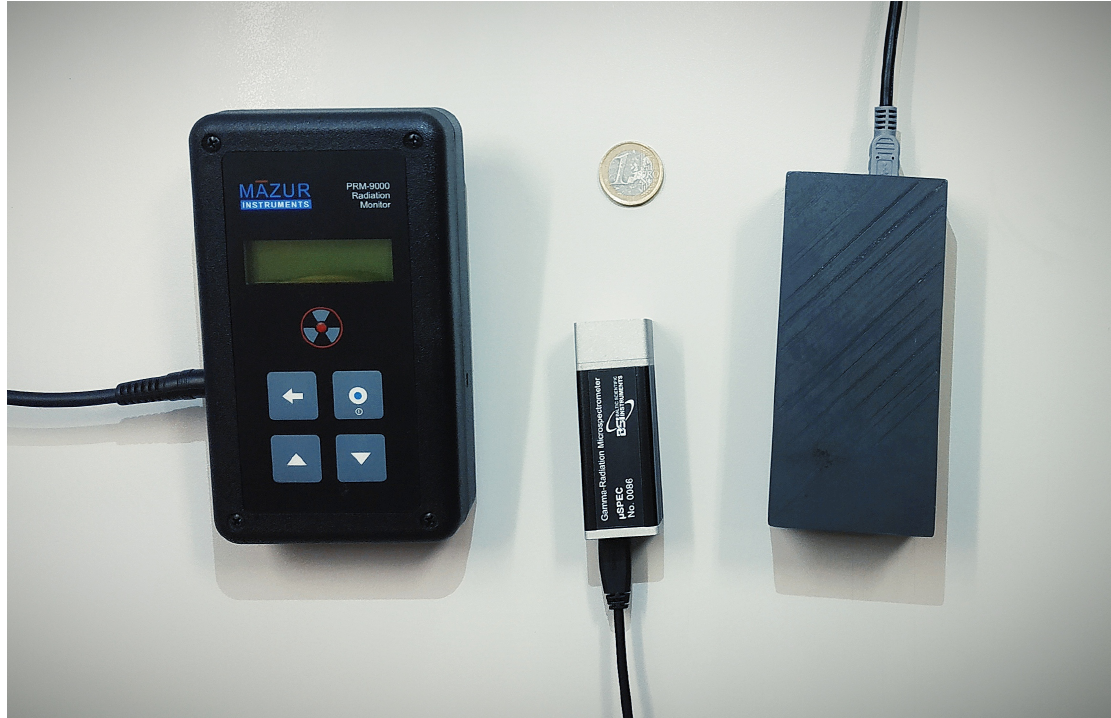
Figure 2. The radiological sensors used in this work. From left to right: the Mazur PRM-9000, the µ SPEC 500 CZT, and the Sparkfun SEN-11345. A 1 euro coin is also present for